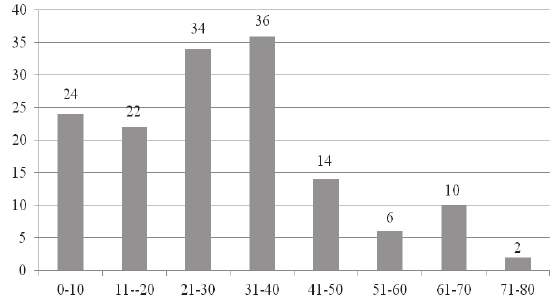
Figure 2 : Bar diagram showing distribution of patients according to age